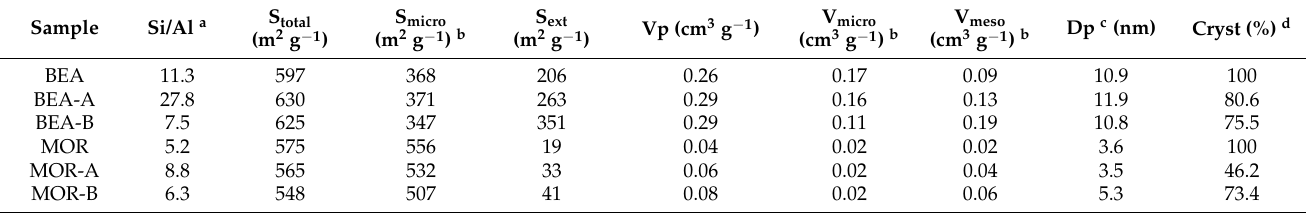
Table 1. Physical-chemical properties of the beta and mordenite